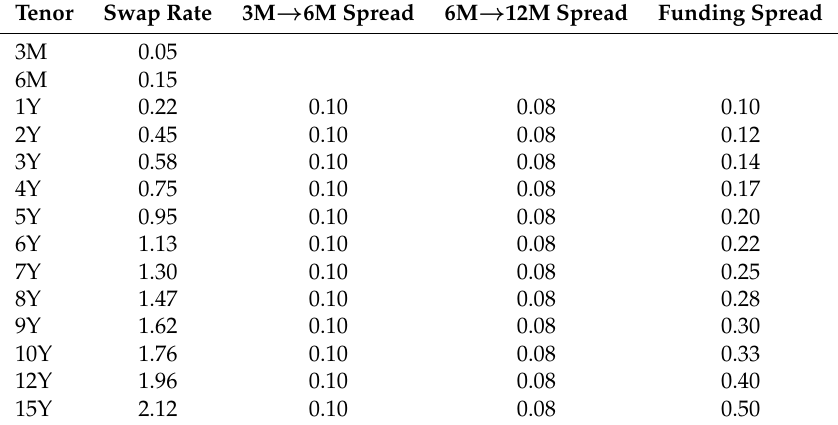
Table 1. Quotes of fixed-to-floating swaps, 3M Ibor against 6M Ibor basis swaps, 6M Ibor against 12M Ibor basis swaps, and funding spreads. All quotes are in percent.